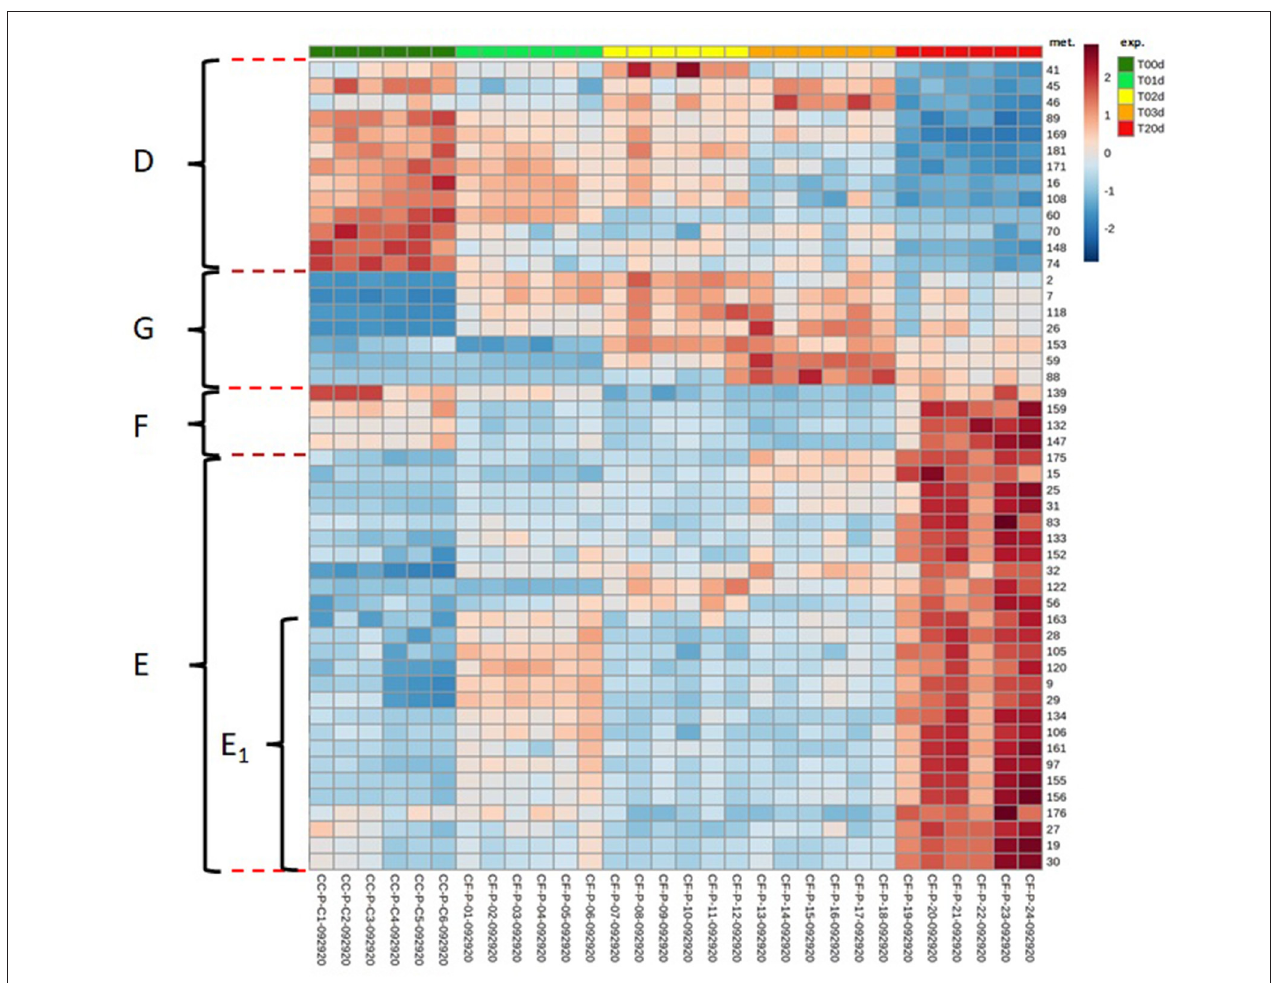
FIGURE 7 | Hierarchical clustering heat maps of the data collected in the time-course experiment performed using the top 50 features from the ANOVA. The figure shows four clusters representing the main temporal trends of the metabolites. D: decrease over time, E: increase over time, F decrease and increase, G: increase and decrease. A subset of metabolites in cluster E shows a more complex trend. The numbers in the heat Maps correspond to the following metabolites (mets): (2) p-coumaric acid; (7) methyl 4-hydroxycinnamate; (9) 3-hydroxy-4-methoxycinnamic acid; (15) 1-O-cinnamoylglucose; (16) 1,6-bis-O-(4-hydroxycinnamoyl)glucose; (19) cynarin; (25) 3-O-feruloylquinic acid; (26) 3-O-p-coumaroylquinic acid; (27) 3,5-dicaffeoylquinic acid; (28) 4-O-caffeoylquinic acid; (29) 4,5-di-O-caffeoylquinic acid methyl ester; (30) 4,5-dicaffeoylquinic acid; (31) chlorogenic acid; (32) chlorogenic acid, methyl ester; (41) 6,7-dihydroxycoumarin-4-acetic acid;